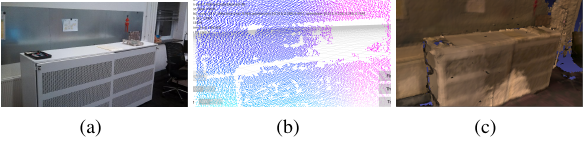
Figure 2: Outputs data provided by the Tango. (a) Real scene. (b) Point cloud generated by the Tango. (c) Textured